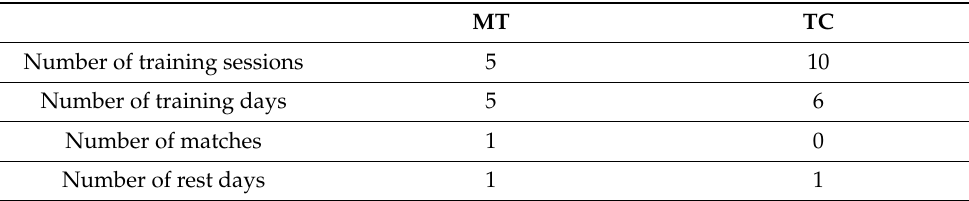
Table 1. The number of training sessions, training days, matches, and rest days throughout the week of moderate training load (MT) and the week of intensive training camp (TC) [4]. MT